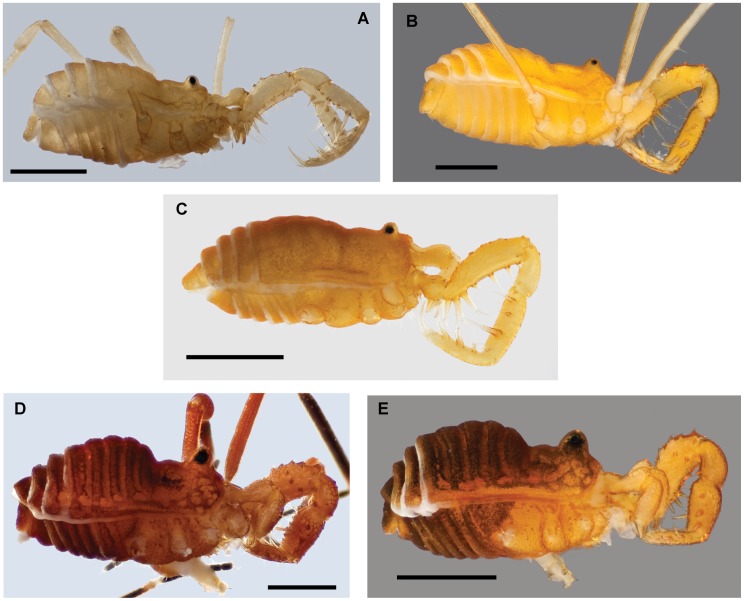
Habitus morphology of the nondimorphicus and cavicolens groups.A) S. cavicolens, male, image horizontally reflected (Lewis and Clark Caverns, MT) [835849]. B) S. ungulatus, male (Model Cave, NV) [835874]. C) S. madhousensis, male (North Madhouse Cave, UT) [835858]. D) S. nondimorphicus, male, image horizontally reflected (Iron Creek, WA) [835861]. E) S. idahoensis, male (Hobo Cedar Grove, ID) [835854]. Scale bars = 1 mm. Morphbank numbers indicated in brackets.